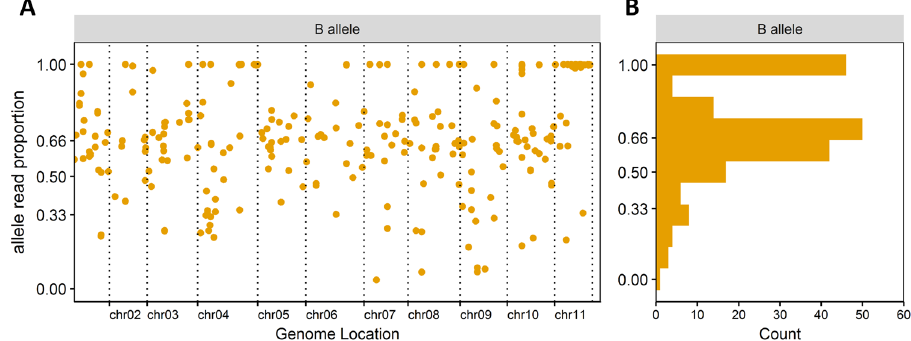
Figure 5. Allele- specific mRNA read proportions at SAAP locations (loci found in uniquely in ABB at the proteomic level) vary between 0 and 1 for the B alleles ( A ). Distribution pattern of the read proportion shows homeolog expression (bias) ( B ). mRNA reads assessed in ABB control samples, separated based on the RNA (codon) translation into ABB and non-ABB specific amino acid sequences.